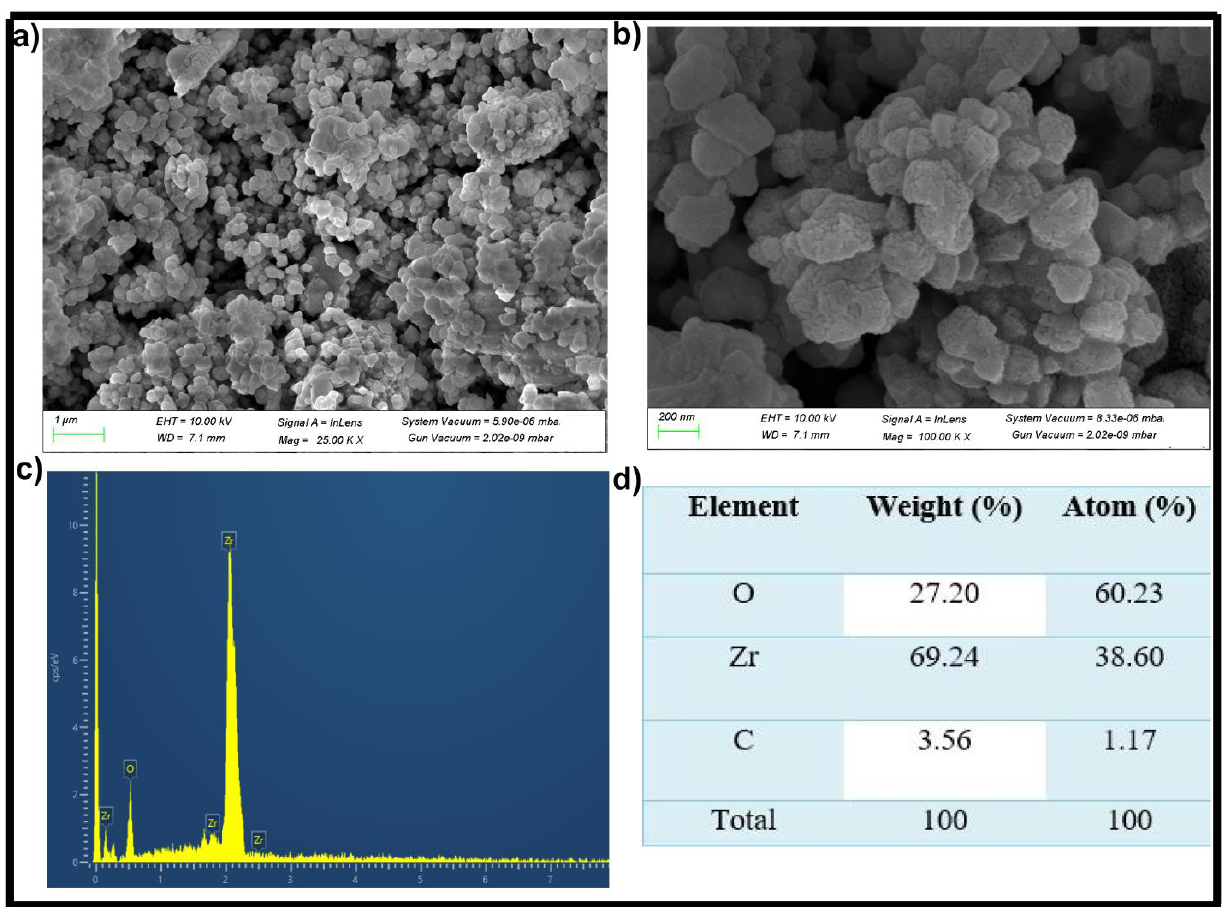
Figure 4. FE-SEM images ( a , b ), EDX spectrum ( c ), and table ( d ) of biosynthesized ZrO 2